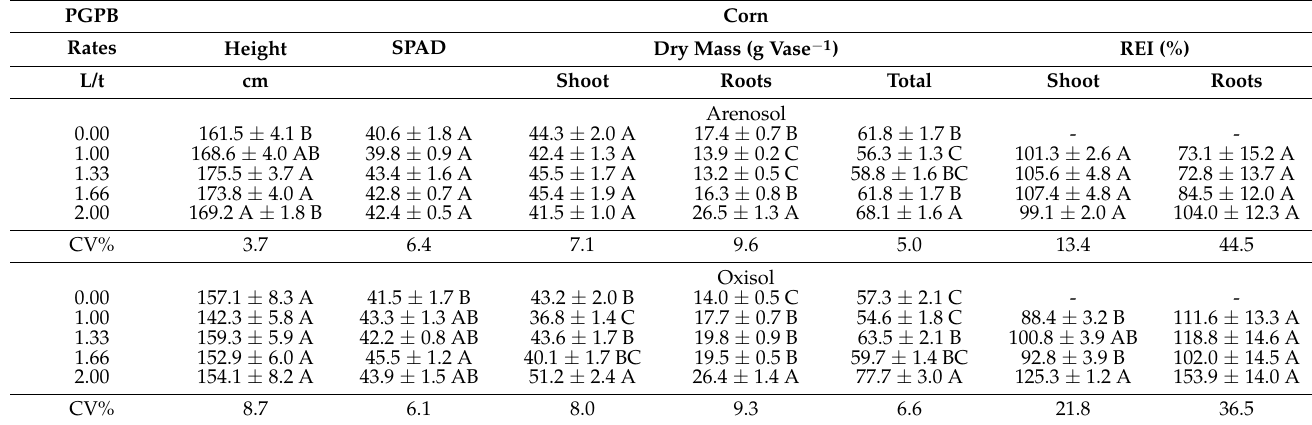
CV: coefficient of variation; averages with the standard error; uppercase letters represent the comparison between treatments (PGPB rates) using the Duncan test ( p -value < 0.05). The general averages of soils and crops were tested by the t -test ( p -value < 0.05). Control is the application of monoammonium phosphate without PGPB. In the arenosol, soybean was not affected by the application of PGPB + MAP on dry matter; however, in the oxisol, it was evident that the application of PGPB + MAP increased the dry matter of roots (up to 31%) and total (up to 8%) as compared to the control. The REI also was higher in the group with the highest rate of 2.0 L/ton of fertilizer in soybean cultivated in the oxisol (Table 2). Table 2. Height, SPAD, dry mass (shoot and root), relative efficiency index (REI) of corn cultivated in an arenosol and oxisol with the application of monoammonium phosphate sprayed with rates of plant growth-promoting bacteria (PGPB; 0; 1; 1.33; 1.66; and 2.0 L/ton of fertilizer). Soybean